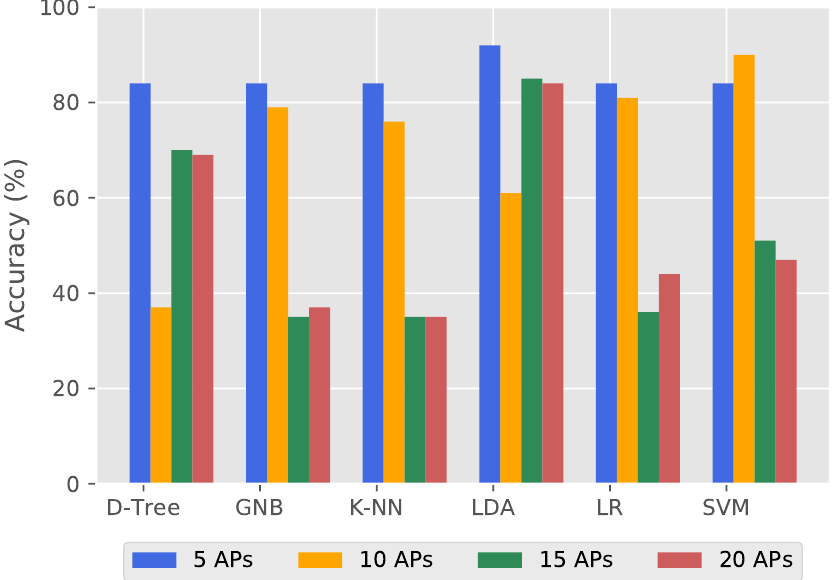
Figure 5. Average accuracy with a different number of APs using the RW mobility model.